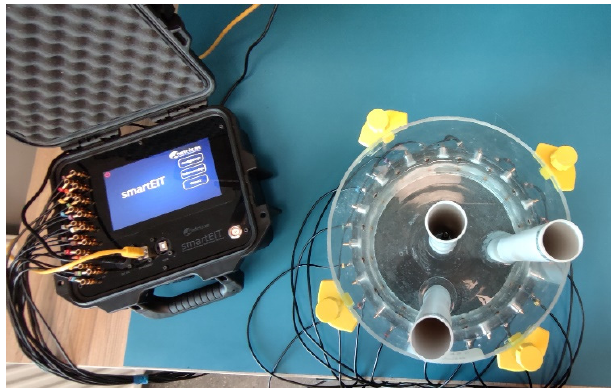
Figure 5. Measuring station with SmartEIT tomograph and physical model of the tank with electrodes and tubes immersed in water.